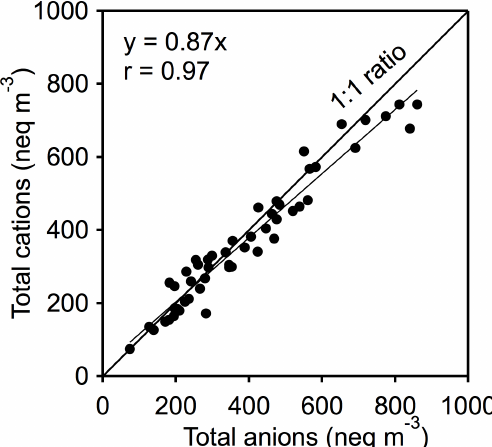
Fig. 9. Linear regression plots between sum of cation equivalents (neq) and anion equivalents (neq) in ambient aerosol samples col- lected from Cape Hedo, Okinawa during October 2009 to October 2010.